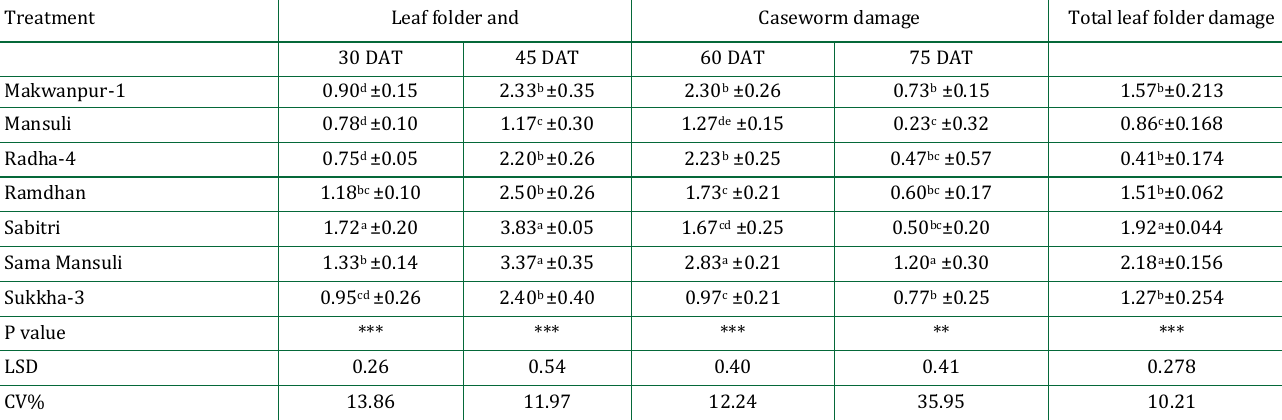
Table 1: Average leaf folder and case worm damage score in different rice varieties under field condition in Chitwan, Nepal, 2019